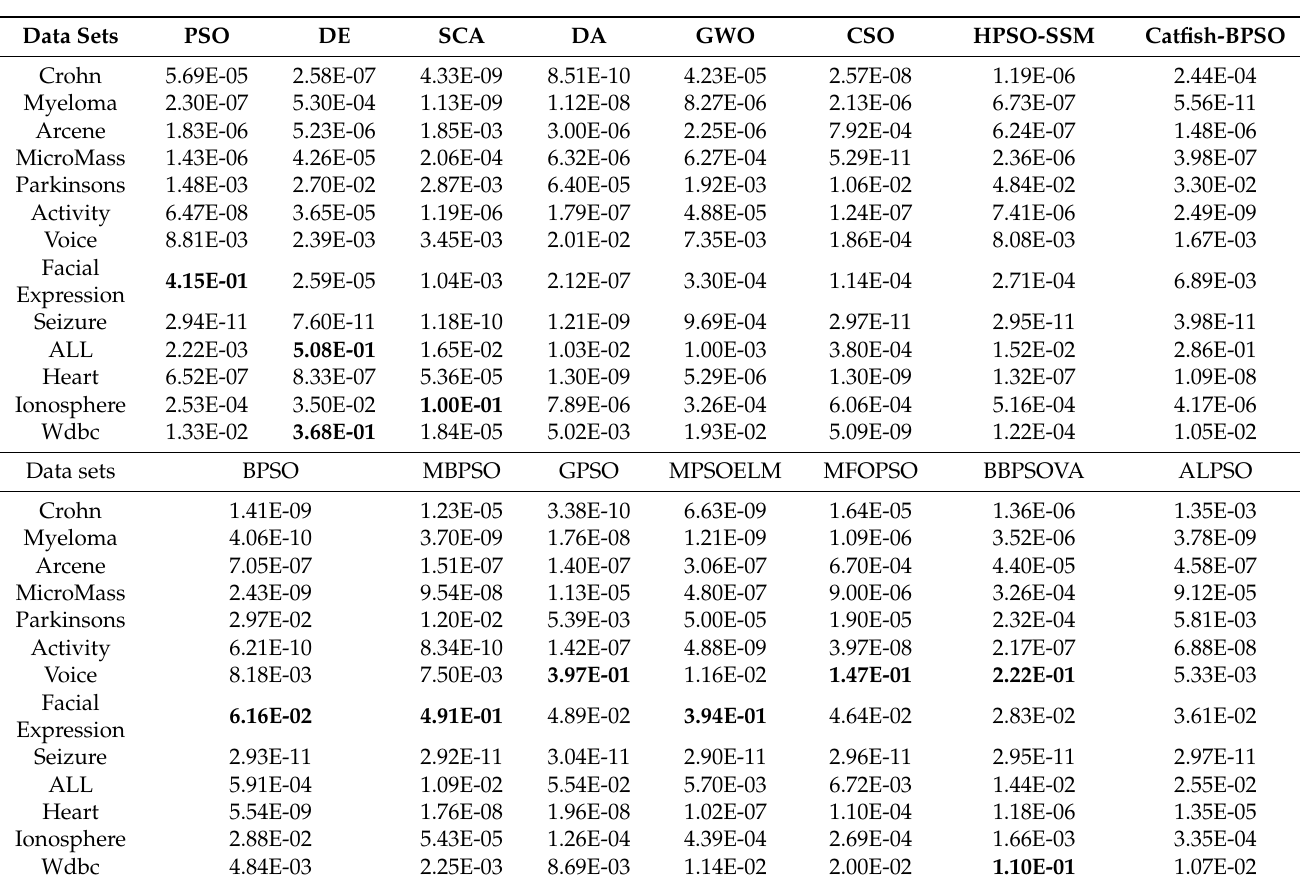
Table 7. The Wilcoxon rank sum test results of the proposed PSOVA2